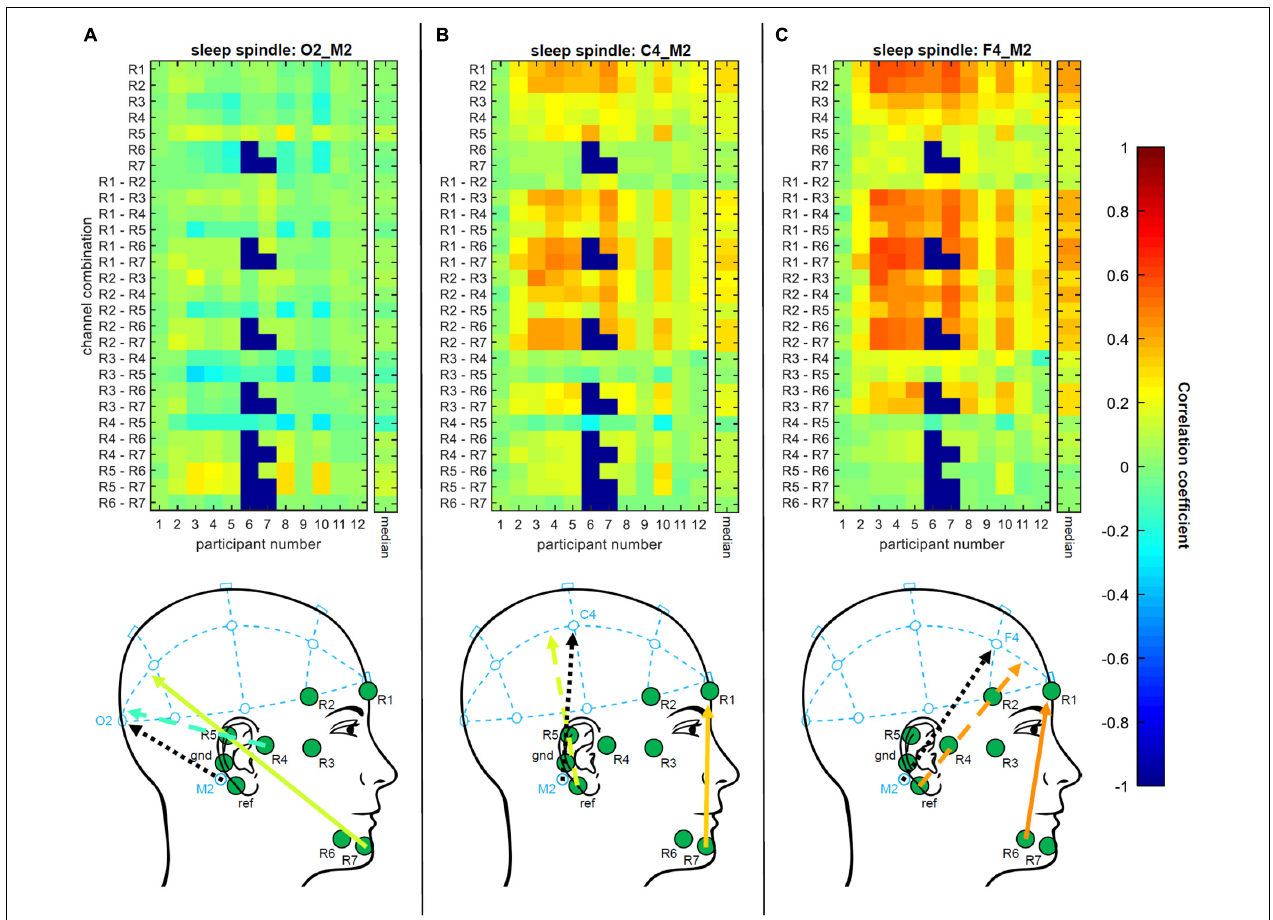
FIGURE 5 | Top: Single participant and median results of all three conditions of the correlation analysis. Correlation coefficients between sleep spindles annotated at EEG of PSG system (using (A) O2_M2, (B) C4_M2 and (C) F4_M2) and the corresponding EEG of every possible single channel and bipolar channel linear combinations of trEEGrid electrodes are calculated, Fisher Z transformed, formed the median over epochs and participants, and transformed back. Bottom: Visual comparison of alignment of PSG system channels (dotted black arrows: O2_M2, C4_M2 and F4_M2) and corresponding trEEGrid channel combinations that scored highest median correlation coefficients (solid colored arrows). Feasible linear combinations of trEEGrid channels placed around ear are shown for each condition (dashed colored arrows). Colors represent the magnitude of correlations. Based on the correlation analysis trEEGrid channel linear combination that either point into the direction of O2_M2, C4_M2 and F4_M2, respectively, or are in parallel to its alignment, result in highest absolute correlation (negative correlations point in the opposing direction of the channel combination) and therefore are best suited to represent sleep spindle reference measurements of the PSG system (O2_M2, C4_M2 and